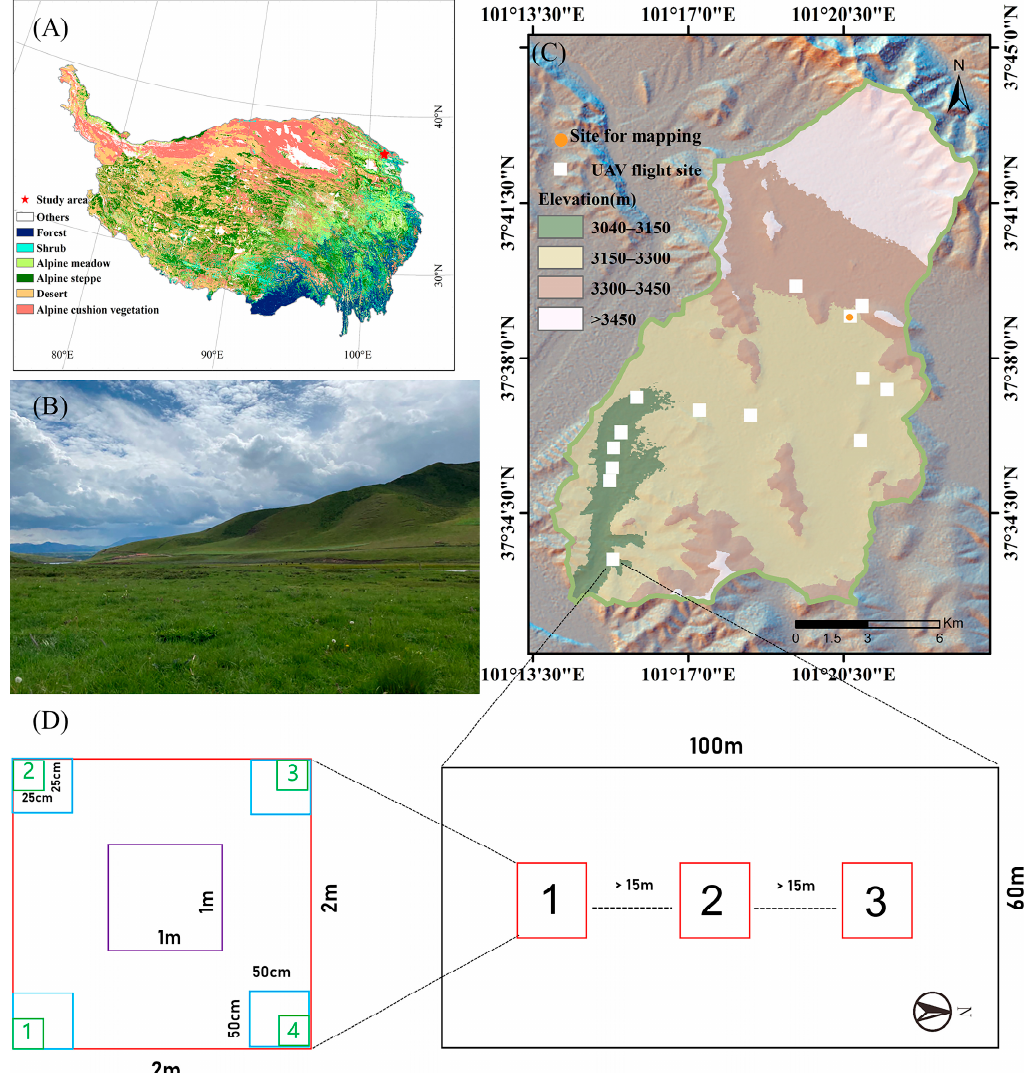
Figure 1. ( A ) Location of the study area on the Qinghai–Tibet Plateau; ( B ) photo of the study area; ( C ) study area with the location of used UAV flight sites; and ( D ) sampling design for each site in which the red boxes denote the three 2 m × 2 m sampling plots, and the green (25 cm × 25 cm), blue (50 cm × 50 cm) and purple (1 m × 1 m) boxes denote the quadrats for biomass harvesting, UAV spectra extraction and species survey, respectively, in each plot. Aboveground biomass in the subplots 1, 2 and 3; 2, 3 and 4; and 1, 3 and 4 for plots 1, 2 and 3, respectively, were harvested after the spectral measurements.